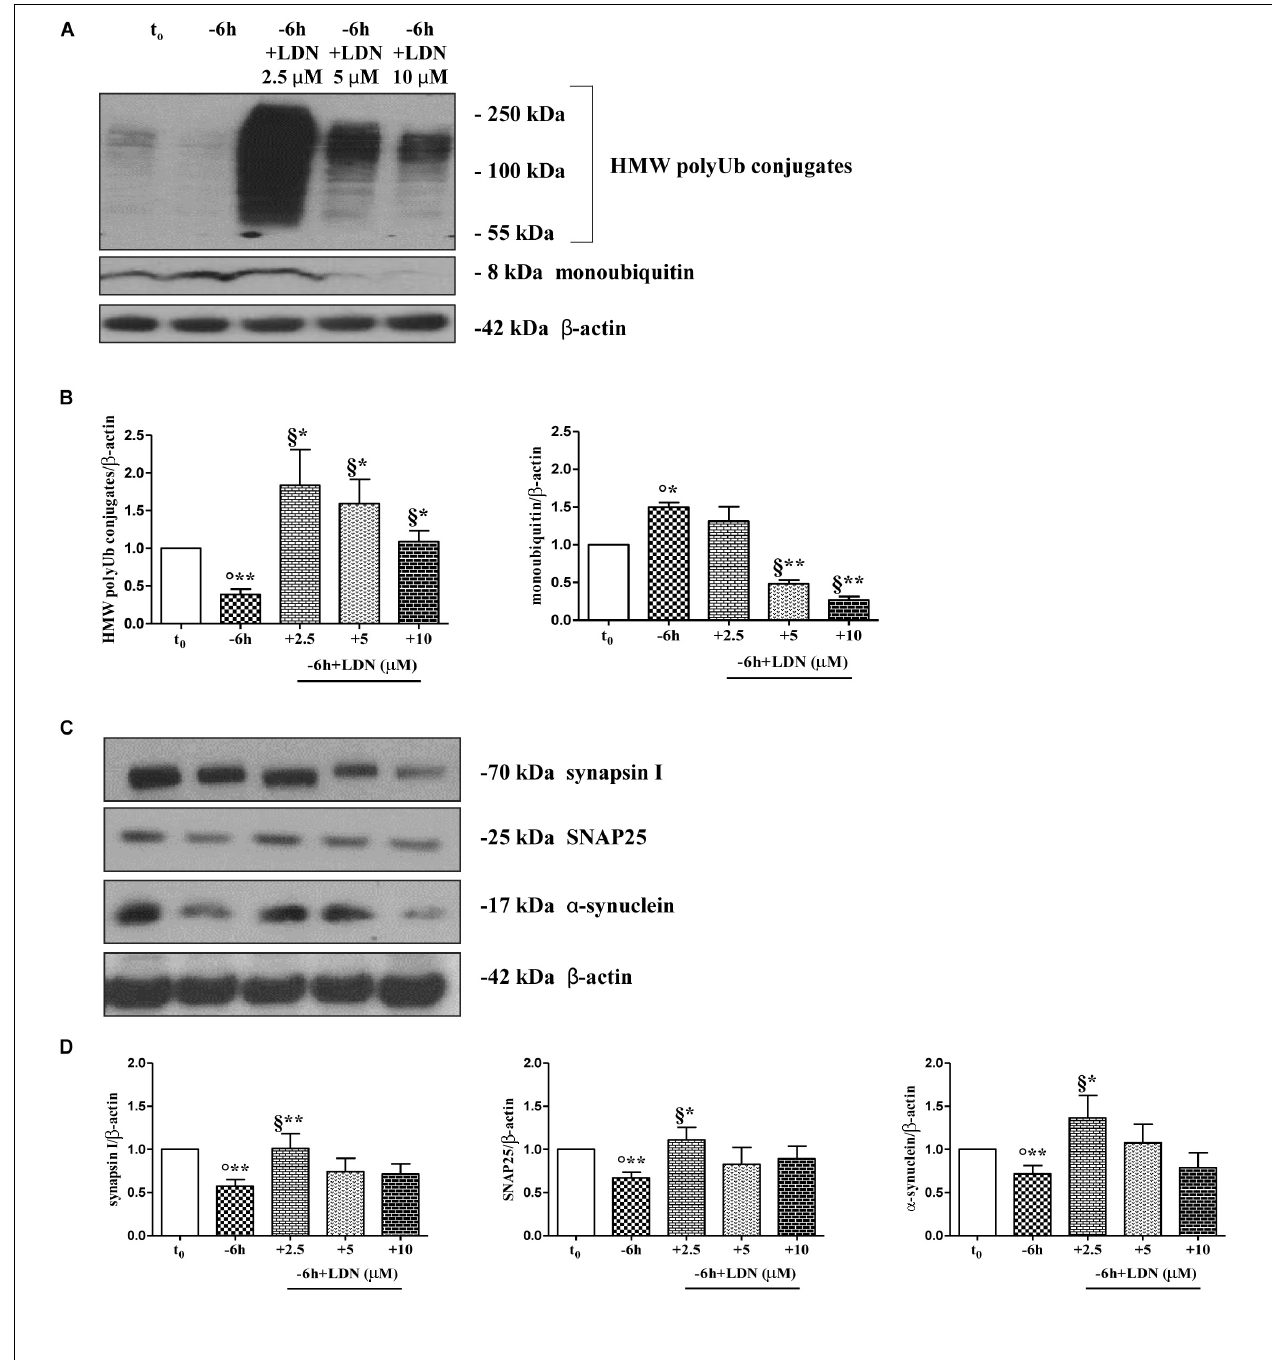
FIGURE 4 | UCHL-1 activity is required to the NGF-dependent control of the synapsin I, SNAP25 and α -synuclein stability in septo-hippocampal primary neurons. (A–D) Septal cholinergic-enriched cultures were grown continuously (10–12 D.I.V.) in 0.2% B27 media in the presence of exogenous NGF (100 ng/ml) from plating ( t 0 ) and then deprived of their trophic support for 6 h (–6 h) in the absence or presence of increasing concentration of LDN (2.5, 5, 10 µ M), a selective and cell-permeable UCHL-1 inhibitor. Representative Western Blotting of sample extracts analyzed for the expression levels of poly-/monoubiquitin (A) , synapsin I, SNAP25 and α -synuclein (C) were shown. Cropped image was shown in (A) . Bar graphs (B–D) showed the densitometric quantification of immunoreactivity levels normalized by calculating the ratio of the intensity of the signal for the protein of interest to that of β -actin which was used as loading control for each sample/lane. Values were mean ± SEM of at least of five independent experiments and were expressed with respect to control neurons ( t 0 ). Statistically significant differences were calculated by unpaired-two tailed t -Student’s test [ ∗ p < 0.05, ∗∗ p < 0.01 vs. t 0 control neurons ( ◦ ) and vs. –6 h NGF deprivation (§)].